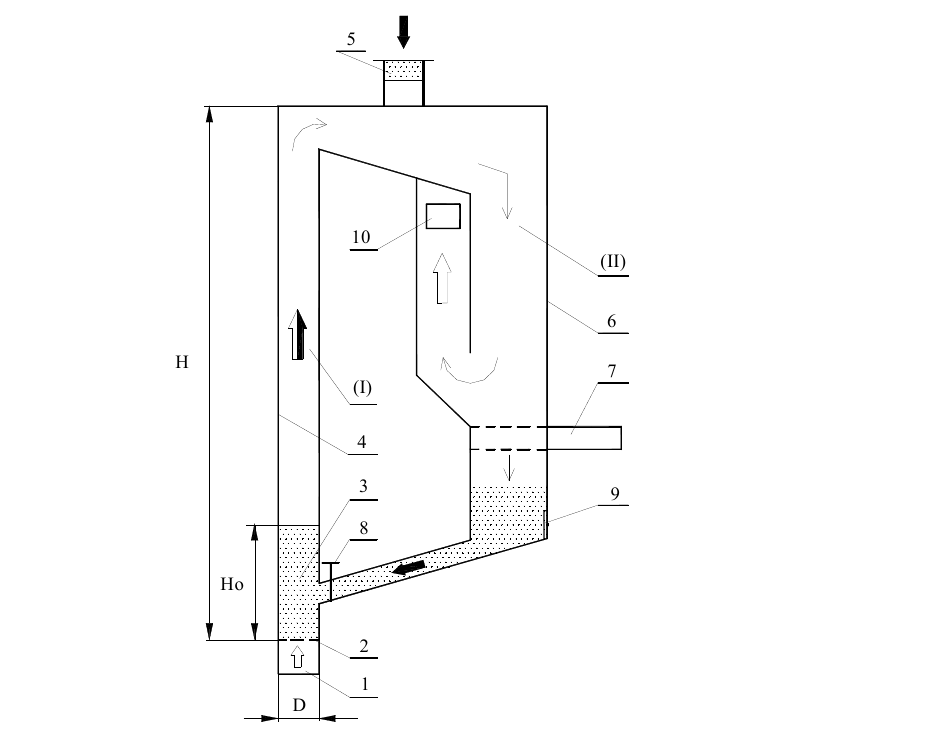
Figure 2. Detailed diagram of the fluidization column (side view): 1—air space, 2—grate, 3—layer of inert material with a height Ho, 4—front glass of the fluidizing column, 5—material supply point, 6—separator rear window, 7—drawer for measuring the amount of circulating material, 8—control valve, 9—material discharge, 10—air outlet for non-separated material.